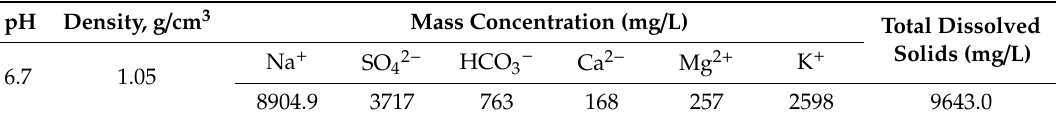
Table 1. The outcrop cores with three di ff erent Klinkenberg gas permeabilities were selected from the Changqing low permeability reservoir. Table 1. Parameters of simulated formation